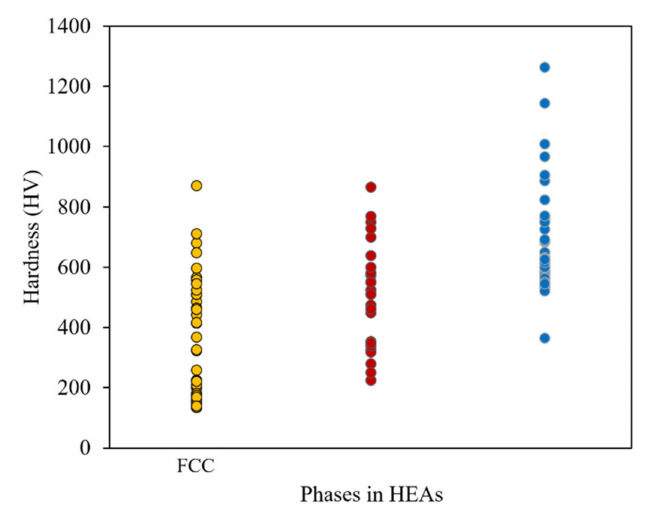
Figure 7. Hardness variation over the major phases of HEAs.